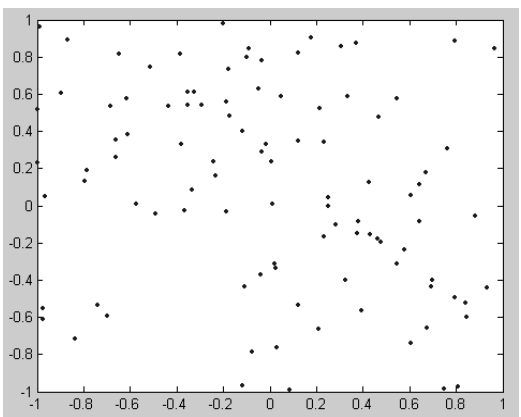
Fig 4. Example for generated data: total number of points N = 100; number of good points on line 20 = 100 (1–80 %); direction angle of normal to given line φ = 0,8 (in rad); distance in Hessian normal form of given line to origin s = 0,2; standard deviation of points on line σ = 0,02